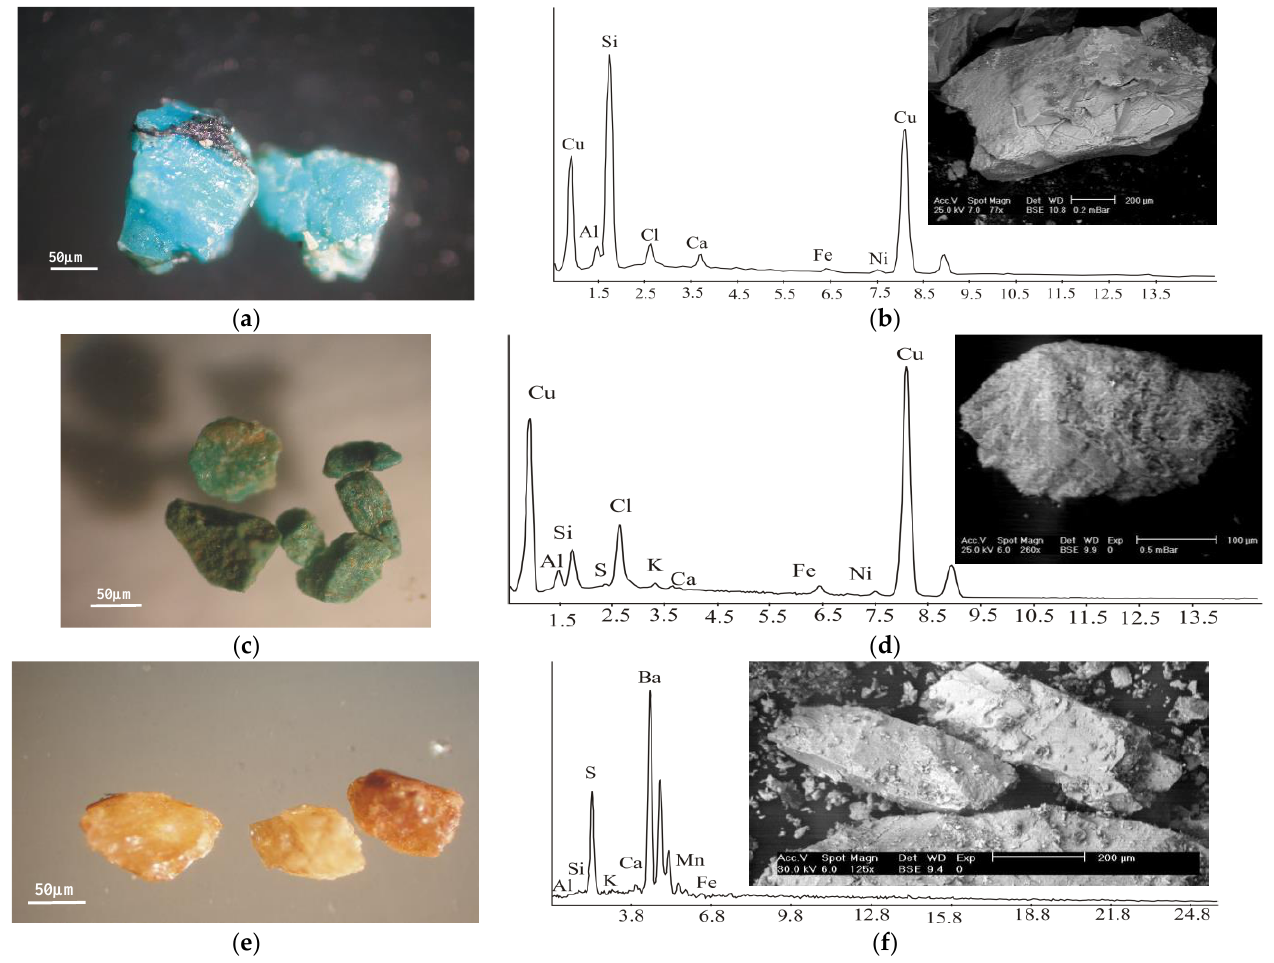
Figure 5. Copper and barite mineralization from monzogranite of Monqul area, north Eastern Desert, Egypt. ( a ) Photomicrographs showing blue grains of chrysocolla under binocular microscope; ( b ) BSE images and EDS chart for chrysocolla; ( c ) photomicrograph showing green grains of tenorite minerals under binocular microscope; ( d ) BSE images and EDS chart for tenorite; ( e ) photomicrograph showing yellowish-brown and brown grains of barite minerals under binocular microscope; and ( f ) BSE images and EDS chart for barite.